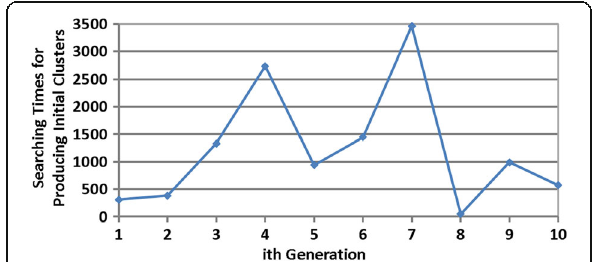
Fig. 3 Searching times for producing initial clusters ten times